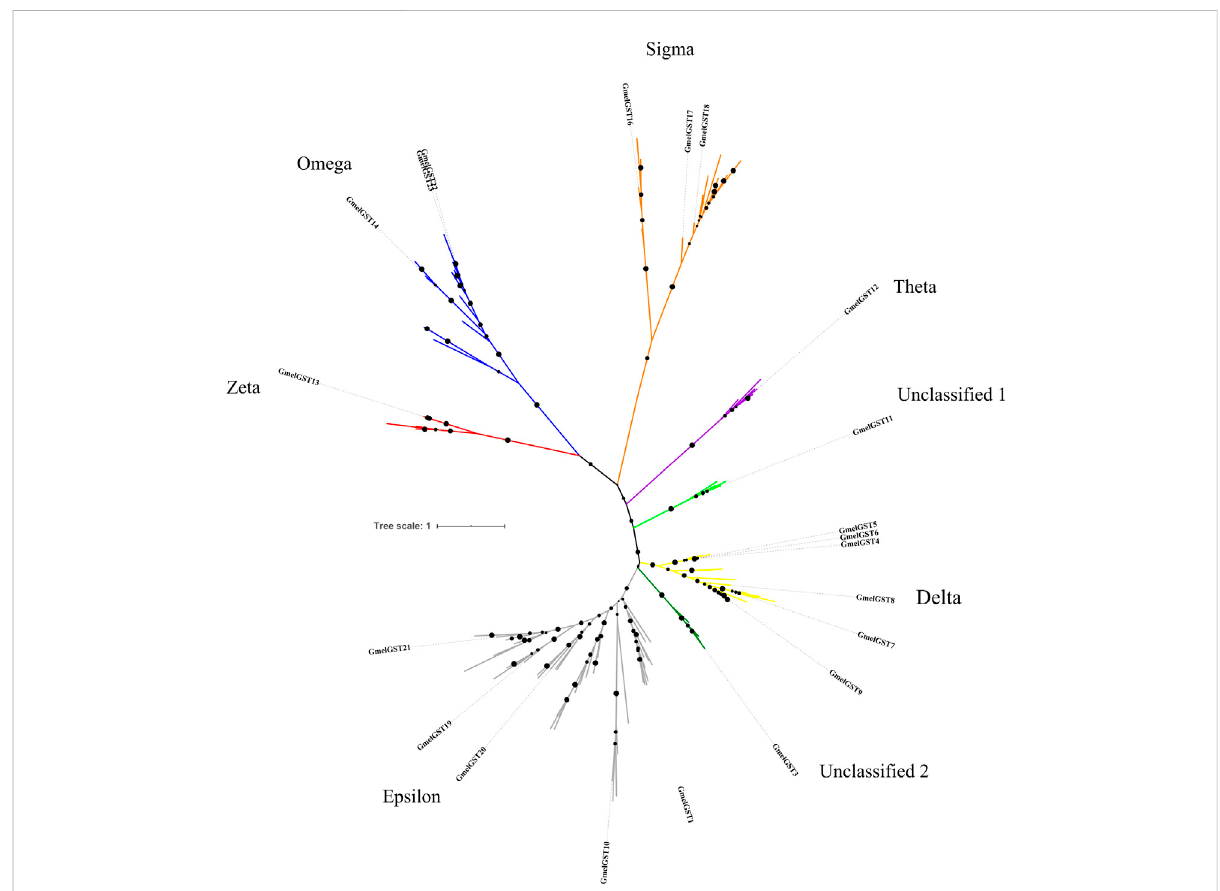
FIGURE 2 Phylogenetic tree for glutathione-S-transferases identi fi ed from G. mellonella transcriptomes. Different GST classes are indicated in red (zeta), blue (omega), orange (sigma), purple (theta), light green (unclassi fi ed 1), yellow (delta), green (unclassi fi ed 2) and grey (epsilon). GmelGSTs are highlighted as bold